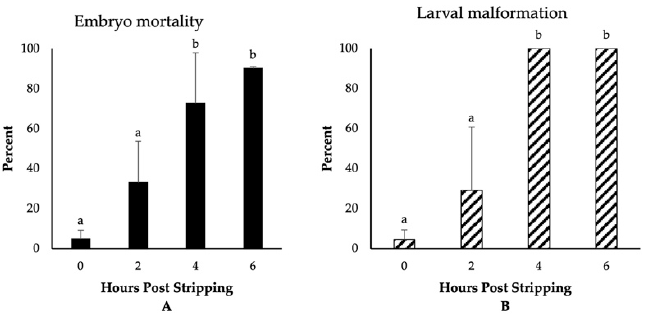
Figure 1. The effect of post-stripping oocyte ageing on the rates of ( A ) fertilization, ( B ) embryo survival, and ( C ) hatching in zebrafish (mean ± SD). Mean values indicated by the same letter (a, b, c) do not differ significantly.